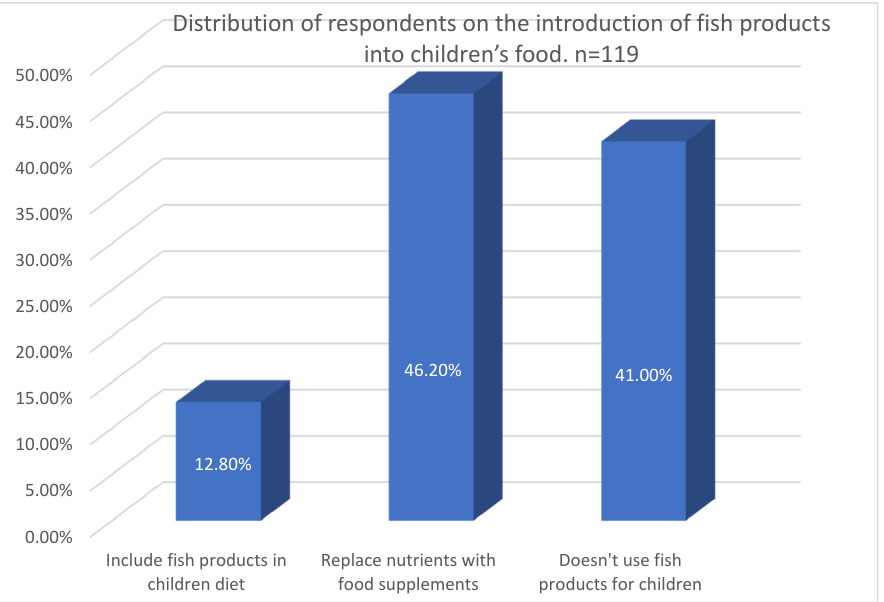
Figure 6. Distribution of respondents on the introduction of fish products into children’s food.